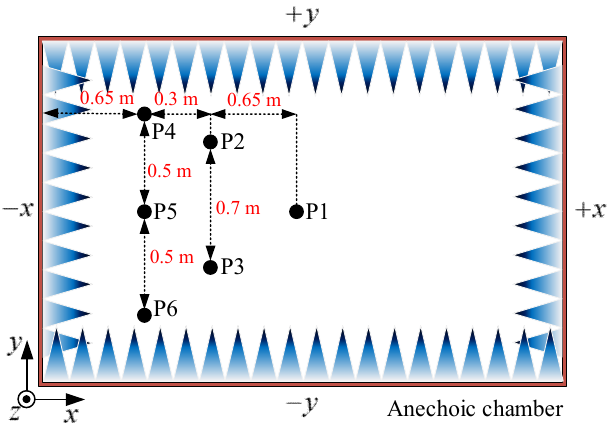
Figure 8. A photograph of chamber B. ( a ) Appearance of the PIM measurement chamber A, ( b ) measurement arrangement in PIM measurement chamber B.